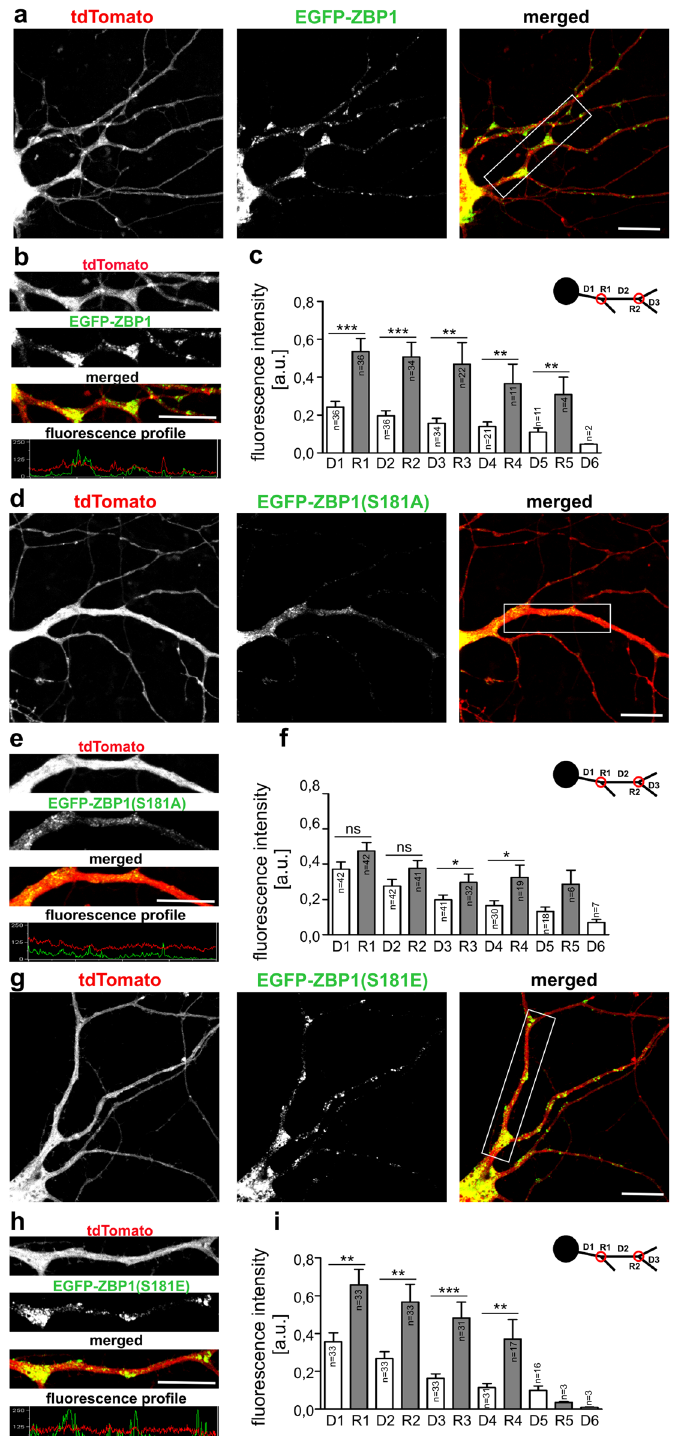
Figure 4. ZBP1 phosphorylation at Ser181 is needed for its proper dendritic distribution. Representative confocal images of hippocampal neurons transfected on DIV7 with pEGFP-ZBP1-P2A-tdTomato ( a ), pEGFP- ZBP1 S181A -P2A-tdTomato ( d ), or pEGFP-ZBP1 S181E -P2A-tdTomato ( g ). Expression proceeded for 30 h. ( b , e , h) Representative micrographs of single dendrites of transfected cells with corresponding profiles of fluorescence. ( c , f , i ) Normalized mean intensities of EGFP-ZBP1 fluorescence ± SEM measured at dendritic branching points (R) and interbranching dendritic segments (D). The data were obtained from three independent neuronal cultures. The data are expressed as mean ± SEM. *** p < 0.001, ** p < 0.01, * p < 0.05, ns - non-significant. Student’s t -test. Number of cells per variant: pEGFP-ZBP1-P2A-tdTomato ( n = 36), pEGFP-ZBP1(S181A)-P2A- tdTomato ( n = 42), pEGFP-ZBP1(S181E)-P2A-tdTomato ( n = 33). Number of analyzed branches for each order is provided in each